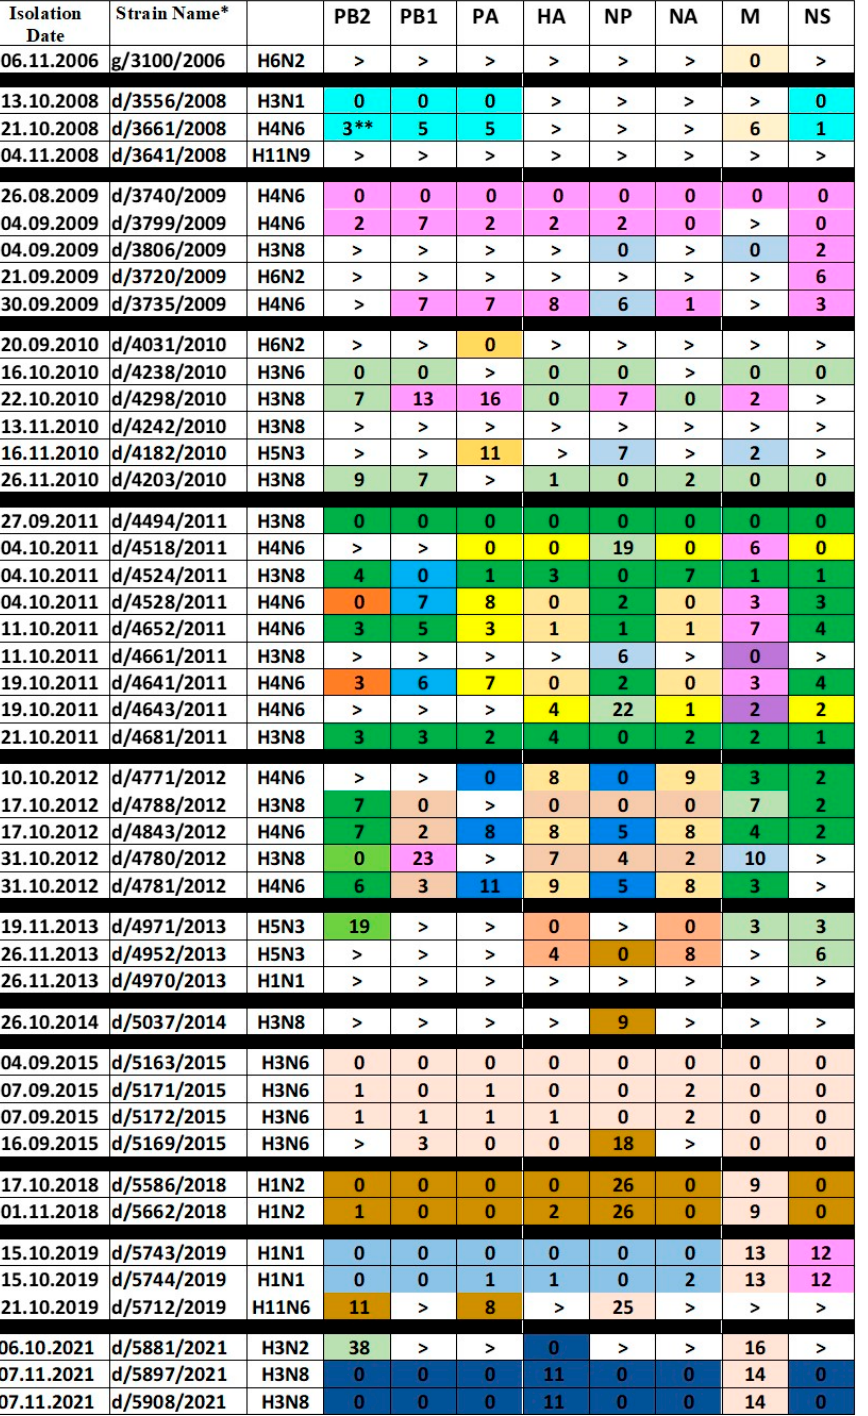
Figure 1. Genome variants of IAVs isolated in Moscow. * The viruses are designated by host (g—gull and d—duck), strain number and isolation year. For example, d/5743/2019 stands for A/duck/Moscow/5743/2019. ** The number in the cell shows the number of nucleotide substitutions with respect to the earlier gene of the lineage marked as “0”. Sign “>” indicates that the gene segment in this cell differed from all other genes in the column by more than 1% of nucleotide substitutions. The same color of the cells in the column depicts gene segments sharing more than 99%